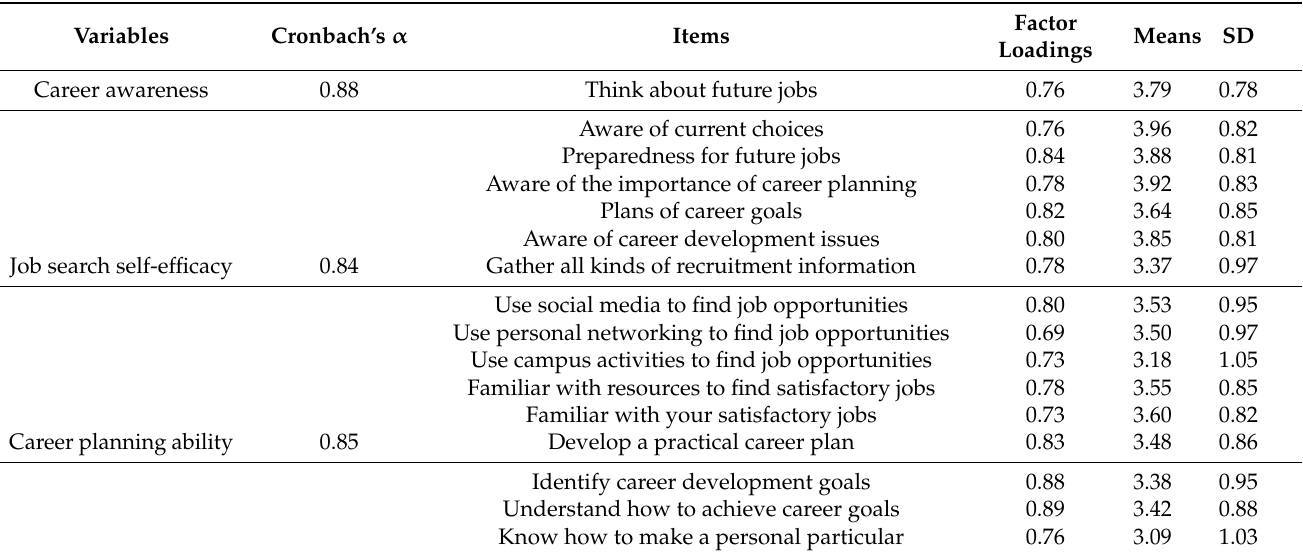
Table 2. Factor analysis results of students’ career-related